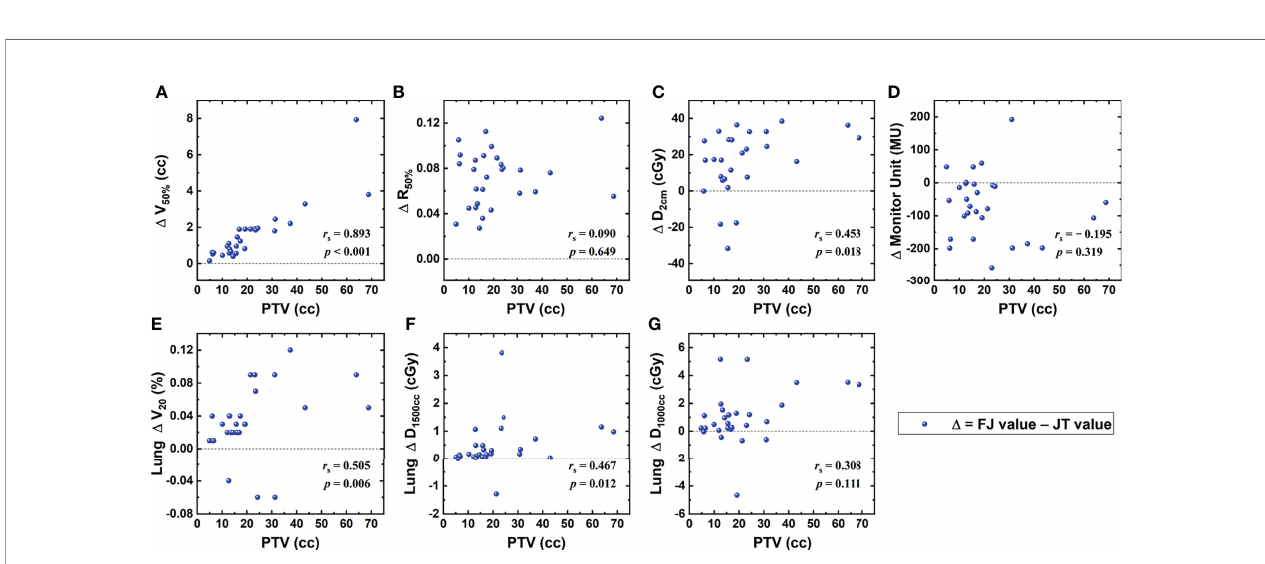
FIGURE 1 | Comparison of dosimetric distributions between fi xed-jaw (FJ; left panel) and jaw tracking (JT; right panel) plans of